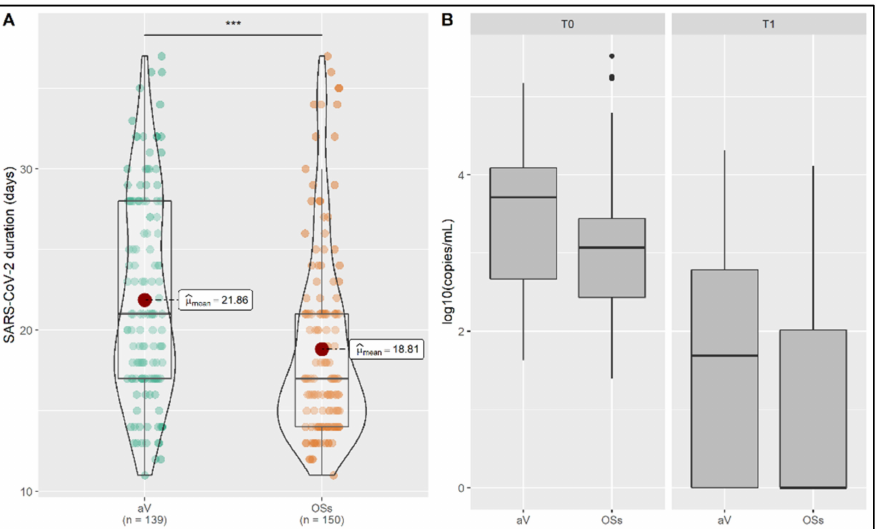
Figure 1. Comparison of OSs and α V carrier individuals. ( A ) The duration of infection significantly differed between OSs and α V carriers. The average day of resolution of infection is reported for each group. ( B ) Viral load and VLDS are shown between groups. Carriers of α V were found with a higher viral load ( p < 0.03); *** p <